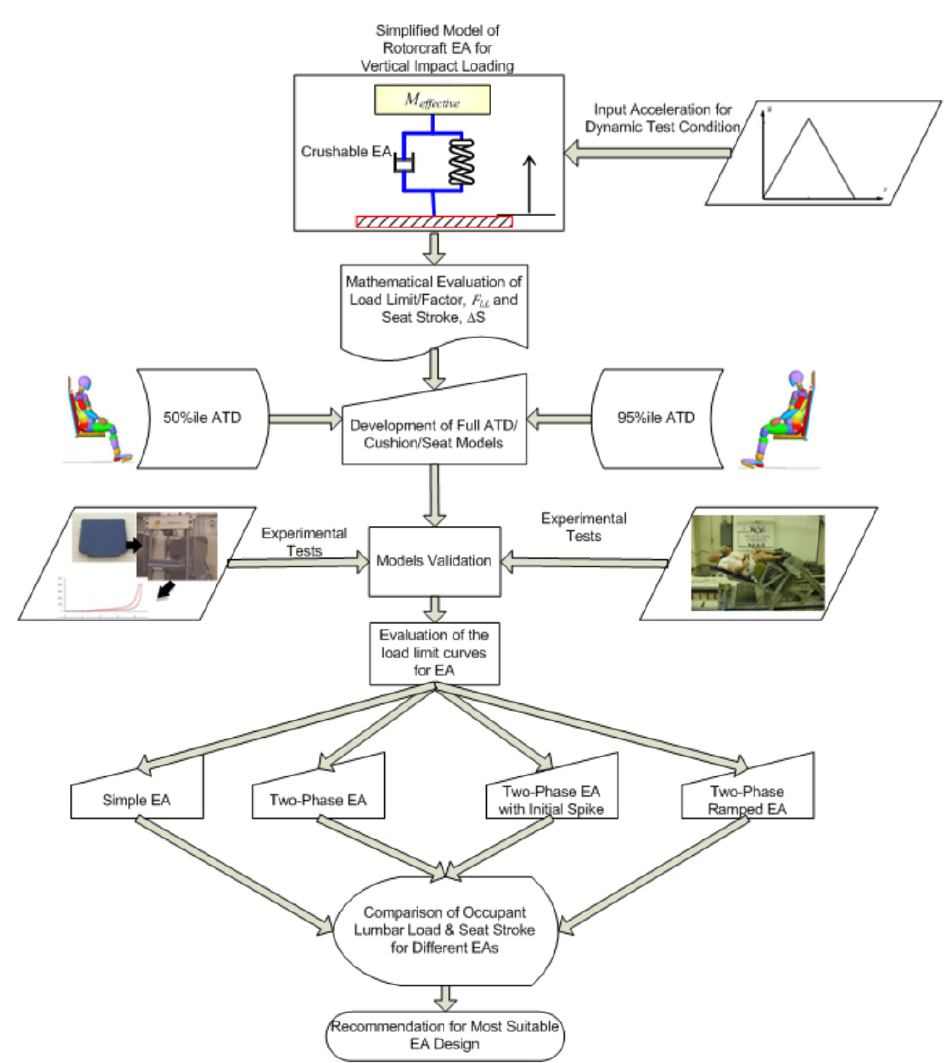
Figure 3. Methodology utilized in this study to design seat energy-absorbing